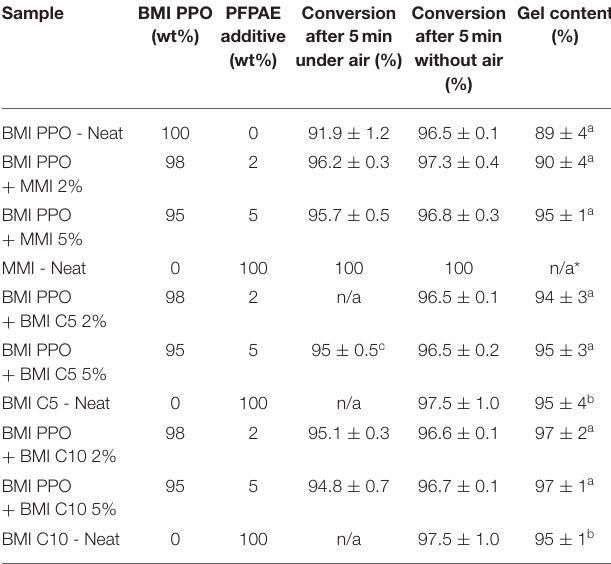
TABLE 1 | Conversion of the maleimide in the presence and in the absence of air for different percentages of